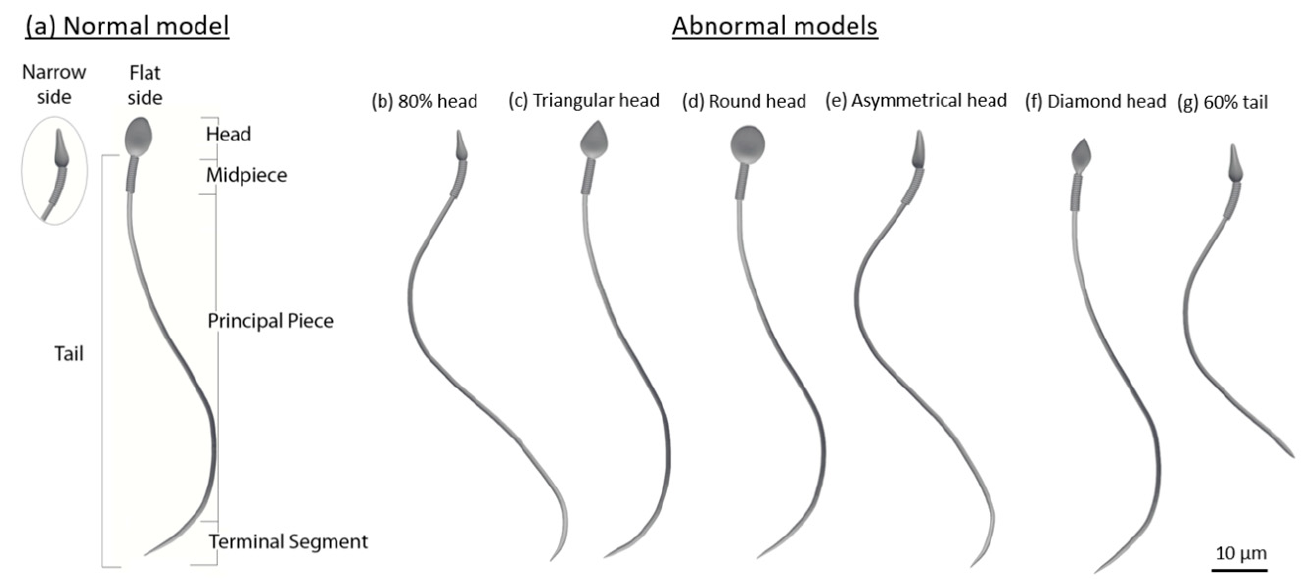
Figure 4. Normal and abnormal sperm cell models (according to the WHO classification [21]). ( a ) Normal sperm cell model. ( b – g ) Different typical morphological abnormalities among the sperm